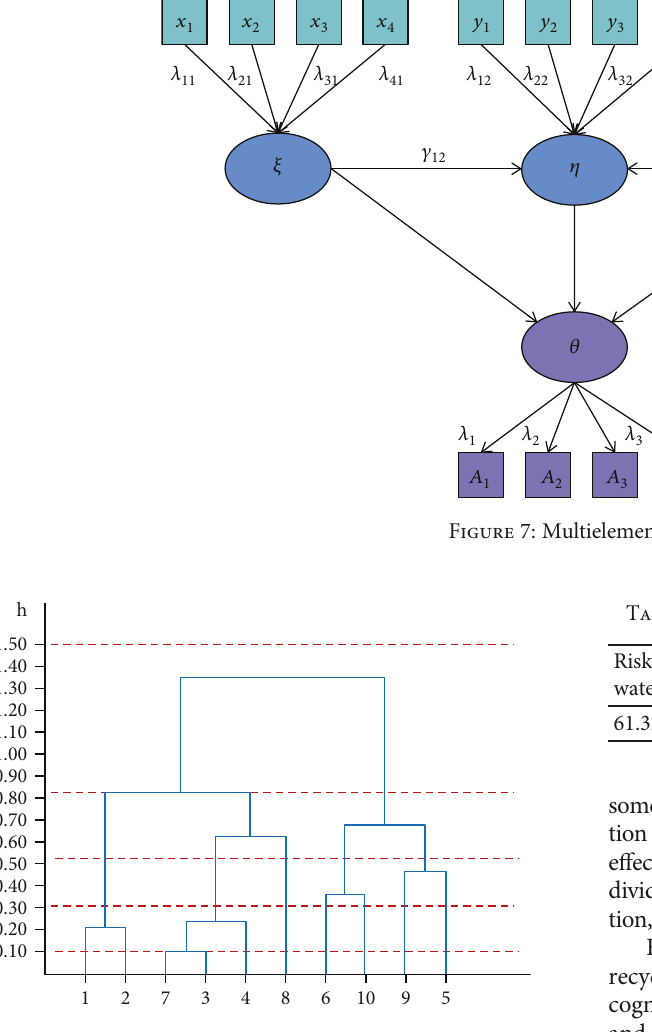
Figure 8: Cluster diagram of 10 indexes of recycled water.